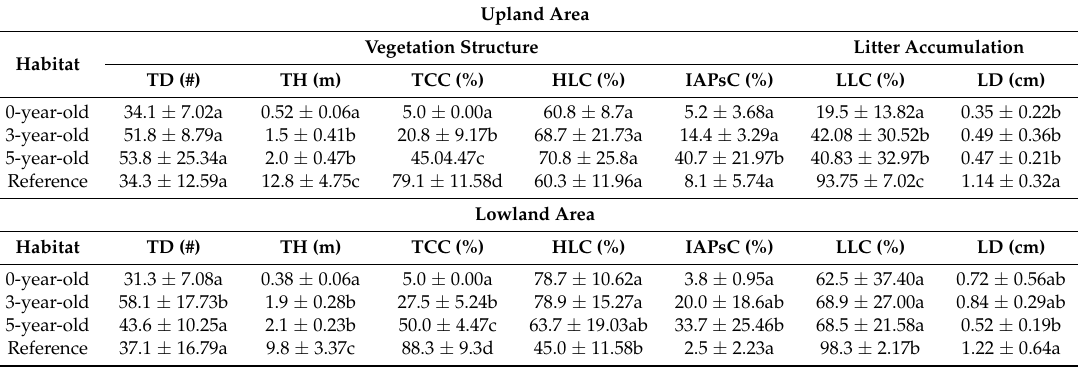
Table 2. Measures of vegetation structure and litter accumulation (mean ±